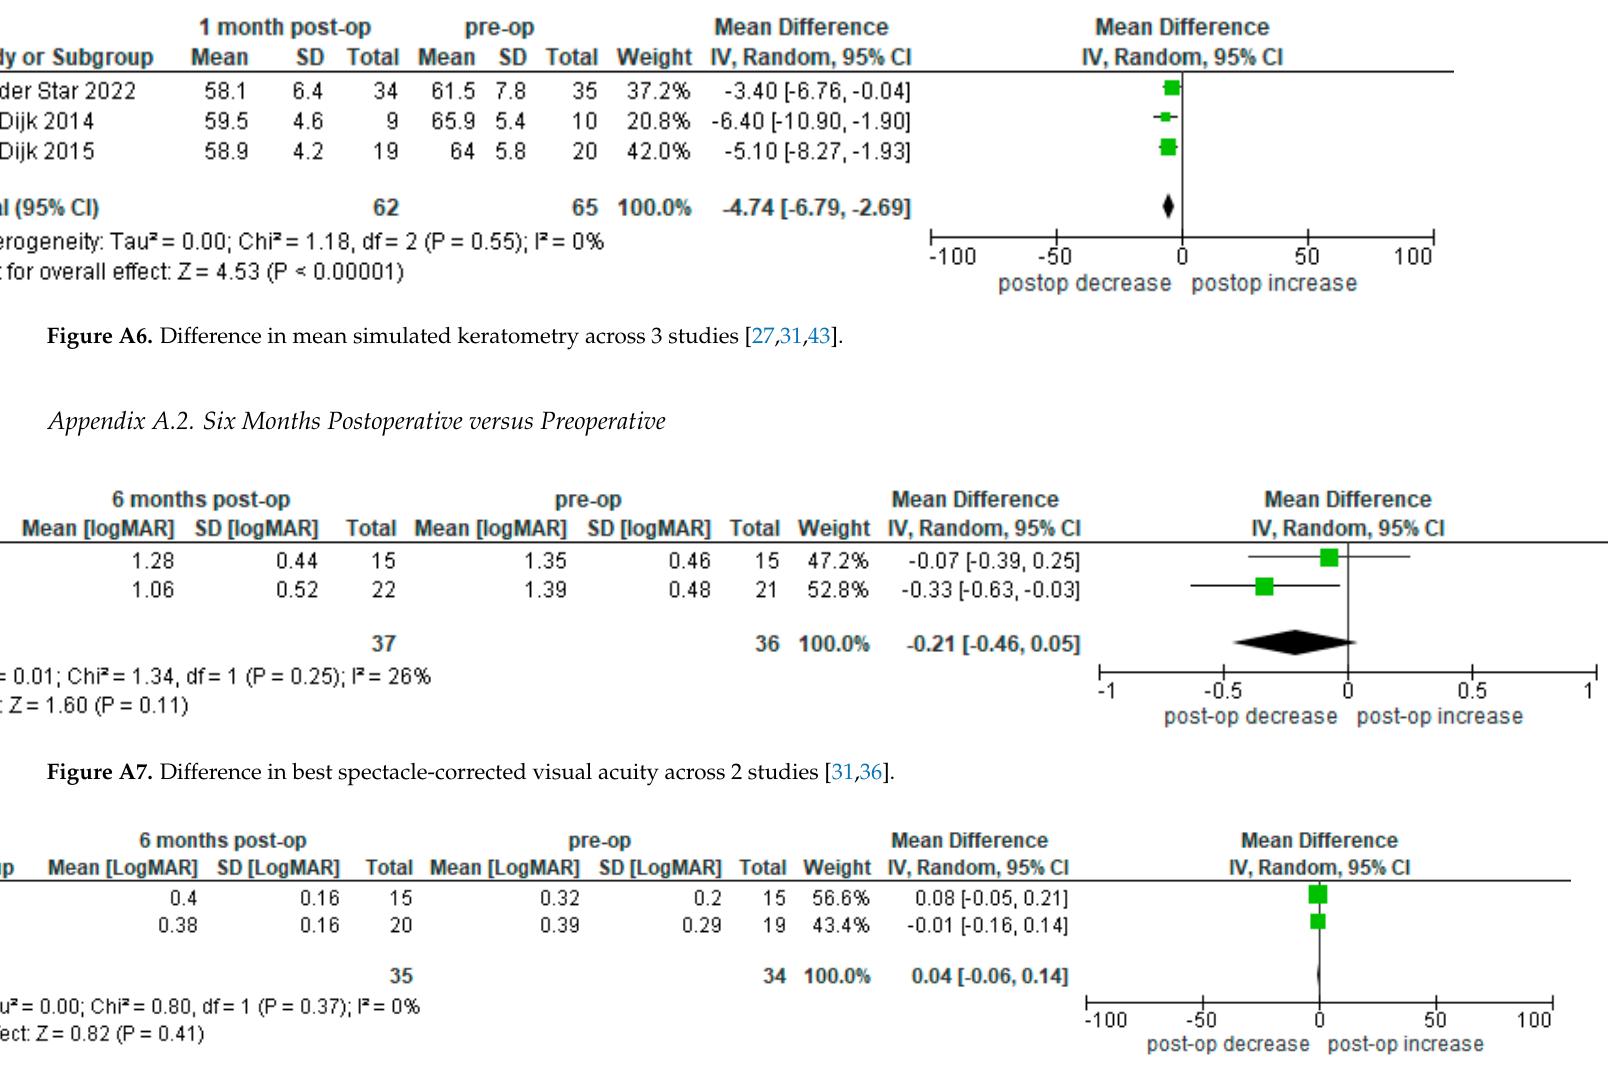
Figure A5. Di ff erence in maximum keratometry across 3 studies [27,31,43].